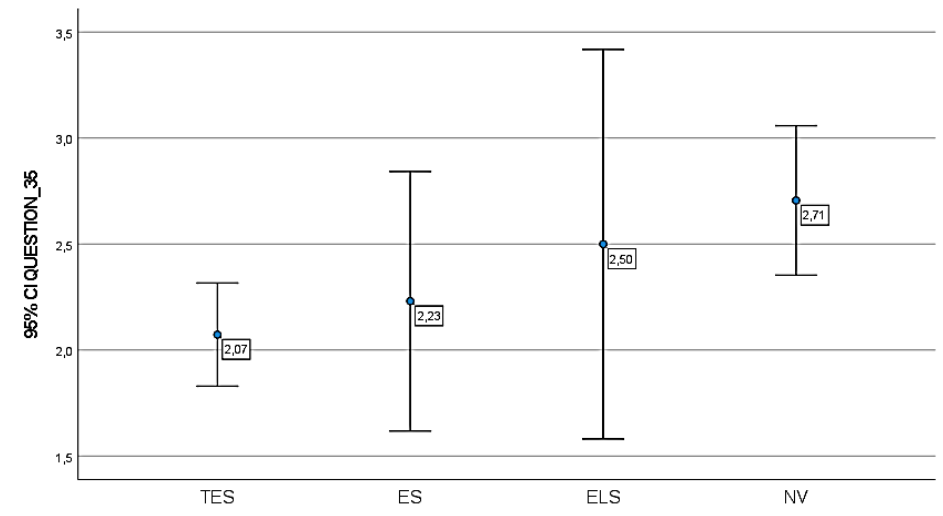
Figure 3. SECEL self-assessment, circle represents the mean, bars represent 95% CIs, labels report the mean. Score legend: cut-off value 36